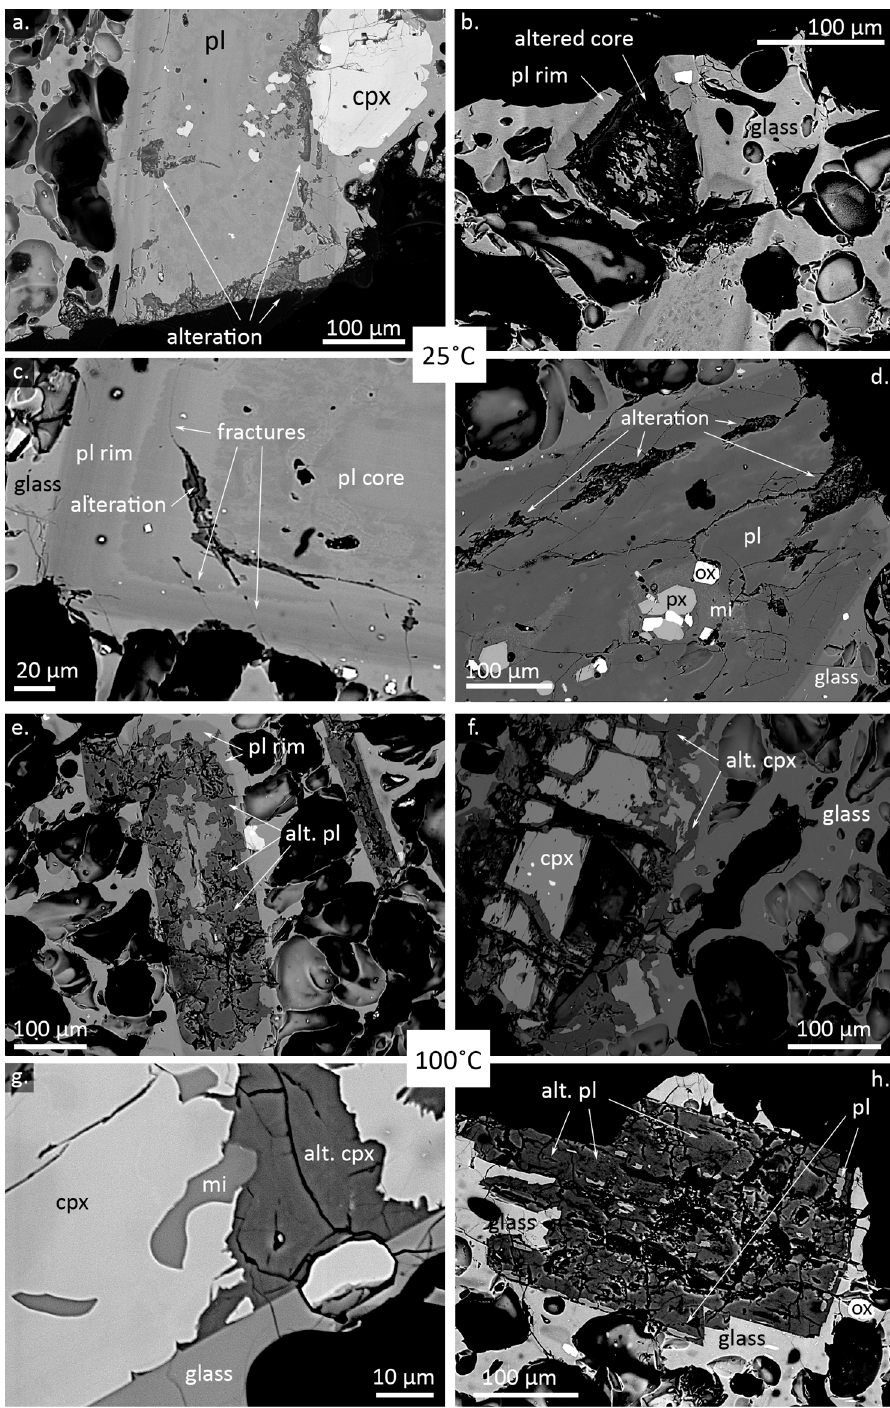
Figure 3. Back-scattered electron images of experimental run products at 25 °C ( a – d ) and 100°C ( e – h ). ( a ) Alteration of a plagioclase phenocryst top opaline silica at the rim of the experiment. ( b ) Strongly altered plagioclase core with intact rim next to pristine glass. ( c ) Preferential alteration of a specific growth zone in plagioclase with fluids access along fractures. ( d ) Alteration of plagioclase at experiment rim without any impact on clinopyroxene, titano-magnetite or glass. ( e ) Intense alteration of plagioclase core with rim partially intact. ( f ) Alteration of clinopyroxene to opaline silica along fractures with the matrix glass unaffected. ( g ) Alteration progressing into clinopyroxene from a fracture with glass in the matrix and present as inclusions unaffected. ( h ) Strongly altered plagioclase with disintegration of the altered core to a void. Abbreviations as in Figure 2.